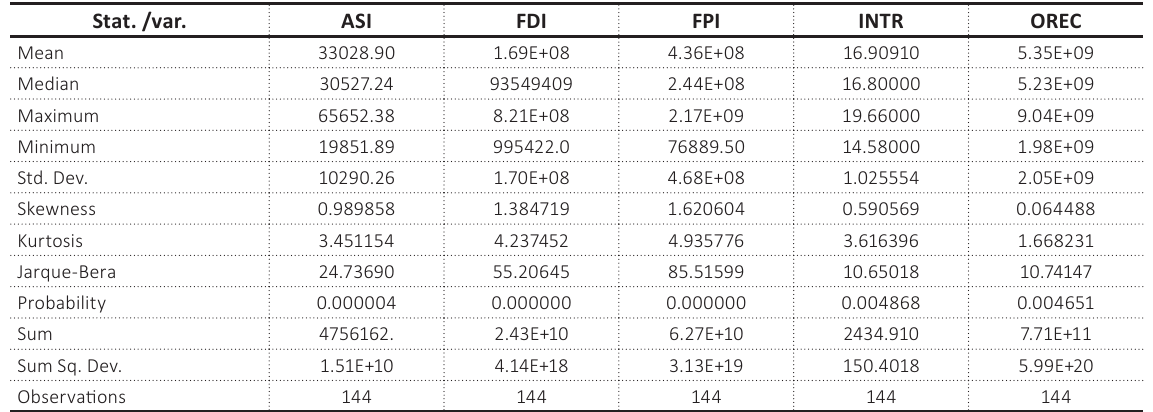
Table 2. Summary